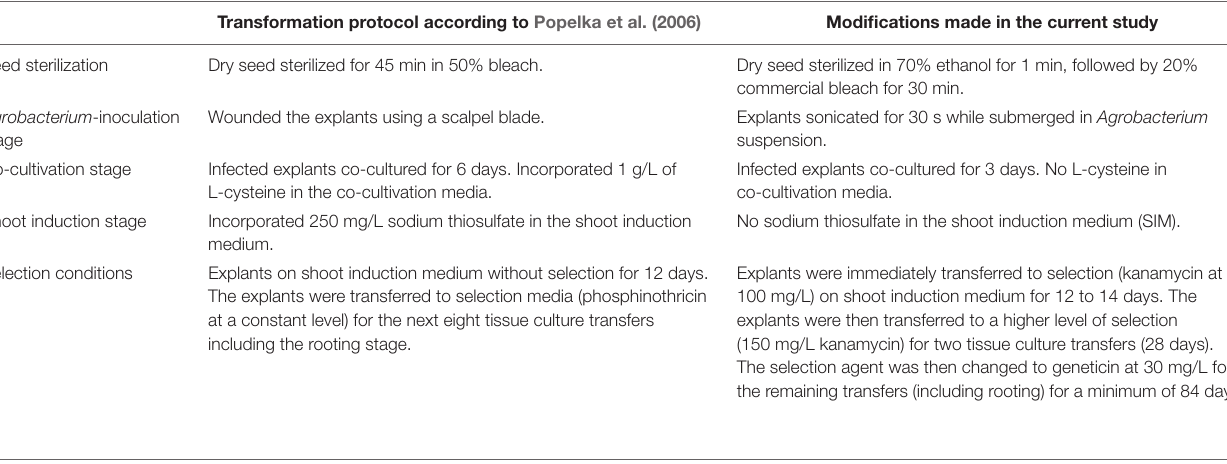
TABLE 4 | Modifications of the transformation system used for cowpea. Transformation protocol according to Popelka et al.